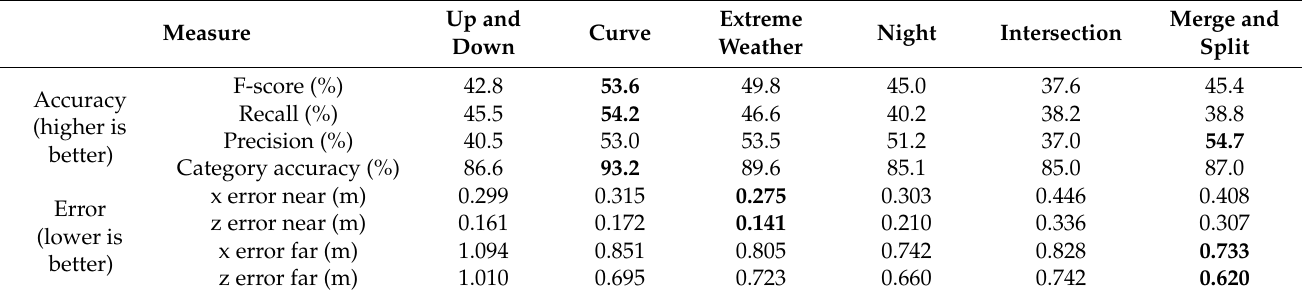
Table 1. Results of eight quantitative measures of the proposed